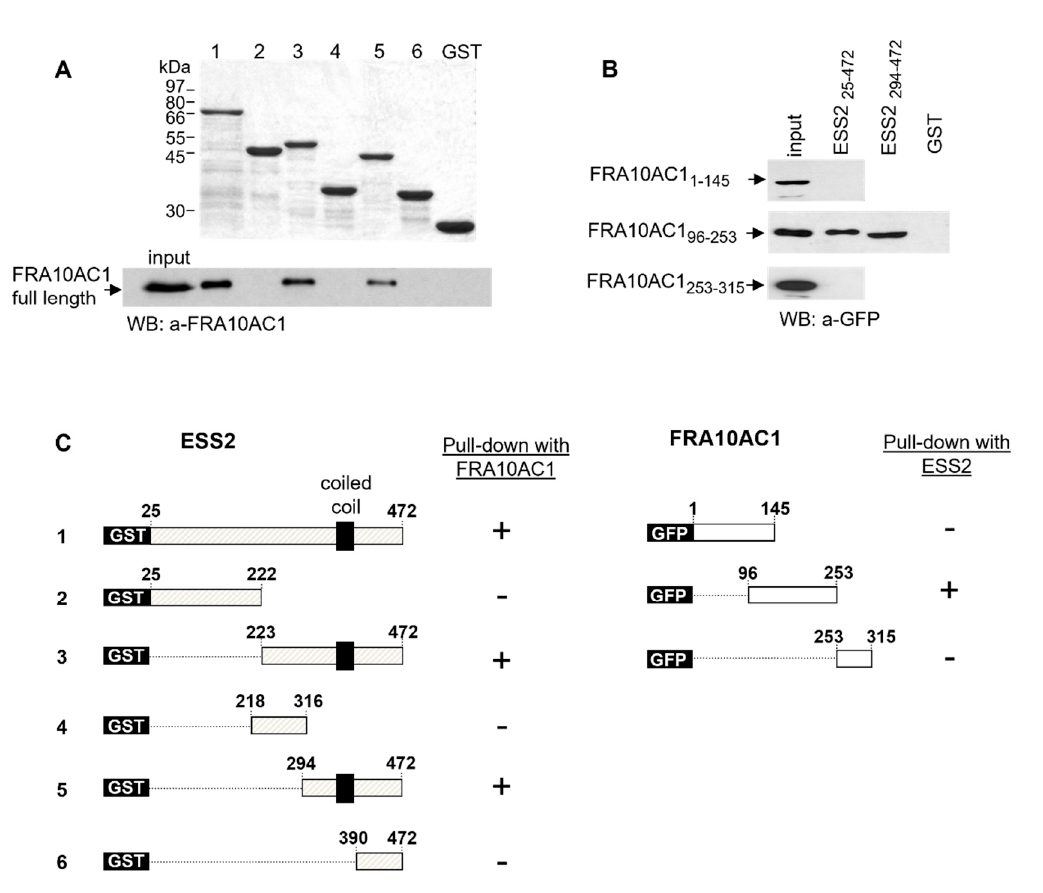
Figure 2. Mapping of FRA10AC1 and ESS2 interacting regions. ( A ) Determination of the ESS2 region interacting with FRA10AC1. Upper: an SDS/PAGE of a bacterially expressed series of GST-ESS2 constructs corresponding to ESS2 aa 25–472, 25–222, 223–472, 218–316, 294–472, and 390–472 (lanes 1–6, respectively), and GST alone (lane 7). Lower: a GST pull-down assay between each one of the truncated ESS2 fragments with the endogenous FRA10AC1 from HeLa cells (~1 mg lysate). Input represents 15% of the lysate used for the assays; an anti-FRA10C1 antibody was used for the Western blot (WB); lanes, same as in upper panel. ( B ) Determination of the FRA10AC1 region interacting with ESS2. Pull-down assay of GST- ESS2 polypeptides corresponding to ESS2 aa 25–472, 294–472, or GST alone with GFP-FRA 1–145 (upper panel), GFP-FRA 96–253 (middle panel), and GFP-FRA 253–315 (lower panel) expressed in transfected HeLa cells. Input represents 10% of the lysate used for each pull-down assay. ( C ) Schematic representation of ESS2 and FRA10AC1 truncated polypeptides used for the mapping.